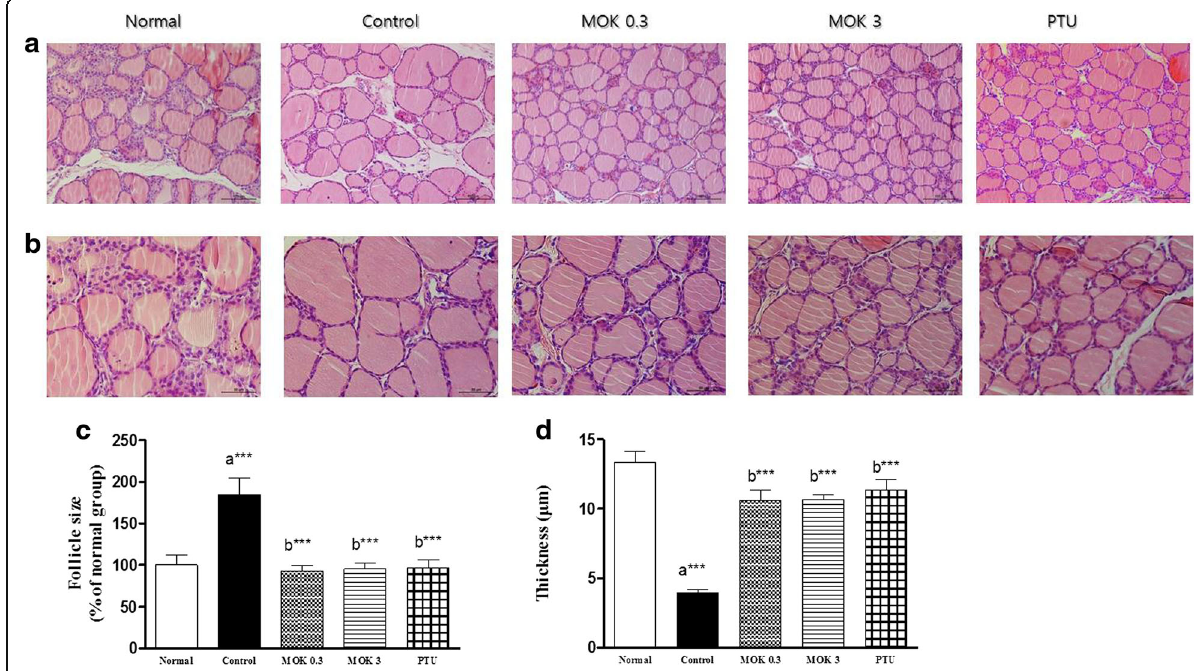
Fig. 6 Effects of MOK pharmacopuncture on the histopathological changes of thyroid tissues in LT4-induced hyperthyroidism rats. MOK pharmacopuncture was subcutaneously administration once daily for 2 weeks, and isolated thyroid glands from the rats. Thyroid tissues were prepared paraffin-formatted slide, and stained with H&E dye. Morphological changes were observed by microscope ×200 ( a ), and ×400 ( b ) in original magnification. The mean of relative follicular sizes to normalgroup ( c ) and the follicular lining epithelium thickness ( d ) were measured in LT4-induced hyperthyroidism rat.Data are presented as mean ± SD ( n = 5 per each group). * P < 0.05, ** P < 0.01 and *** P < 0.001 vs normal ( a ) or control ( b ). Normal, normal group; Control, LT4-induced hyperthyroidism group; MOK 0.3, MOK 0.3 mg/kg-treated group in control; MOK 3, MOK 3 mg/kg-treated group in control; and PTU, PTU 10 mg/kg-treated group as a reference